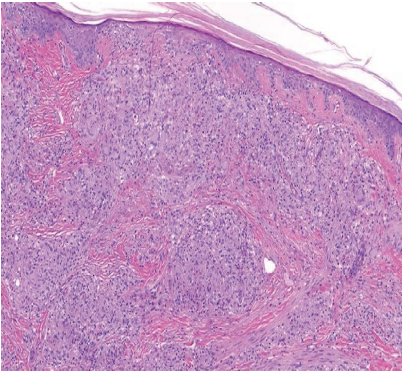
Figure 4: H&E-stained biopsy specimen at 40x